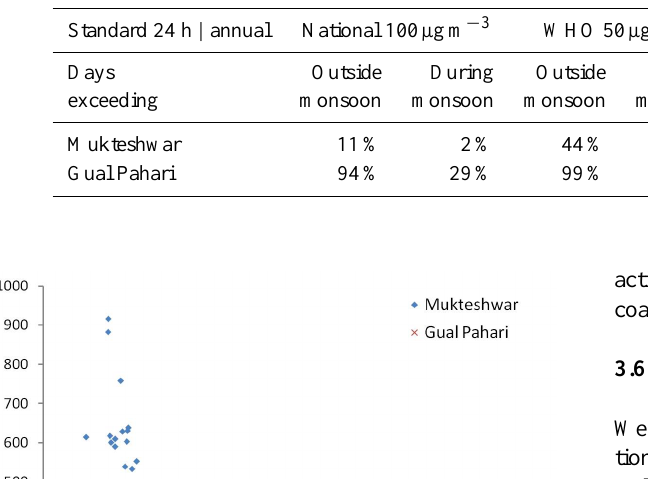
Table 5. Percentage of days exceeding the 24h PM 10 guideline value set either by the National Air Pollution Board or the WHO. In addition the campaign averages are shown in ambient concentrations with and without the monsoon season.